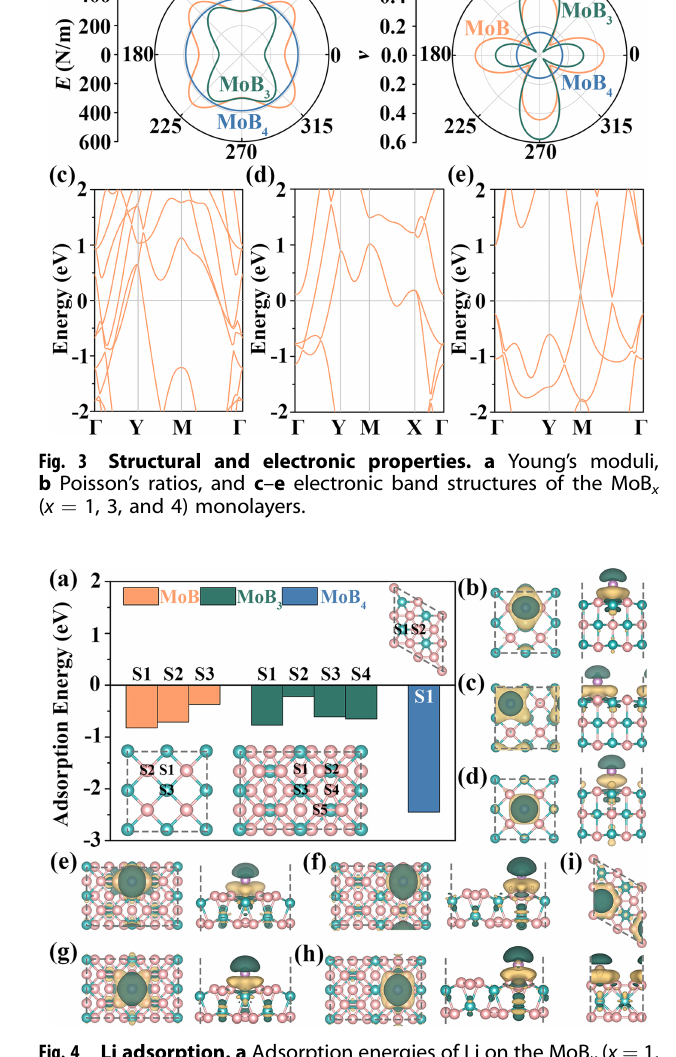
Fig. 4 Li adsorption. a Adsorption energies of Li on the MoB x ( x = 1, 3, and 4) monolayers. The insets show the considered adsorption sites. Top and side views of the charge redistributions induced by the interaction of Li at the b S1, c S2, and d S3 sites with the MoB monolayer, by the interaction of Li at the e S1, f S2, g S3, and h S4 sites with the MoB 3 monolayer, and by the interaction of Li at the i S1 site with the MoB 4 monolayer. Green and yellow isosurfaces (isovalue: 0.01 electrons/Å 3 ) represent charge depletion and accumulation,